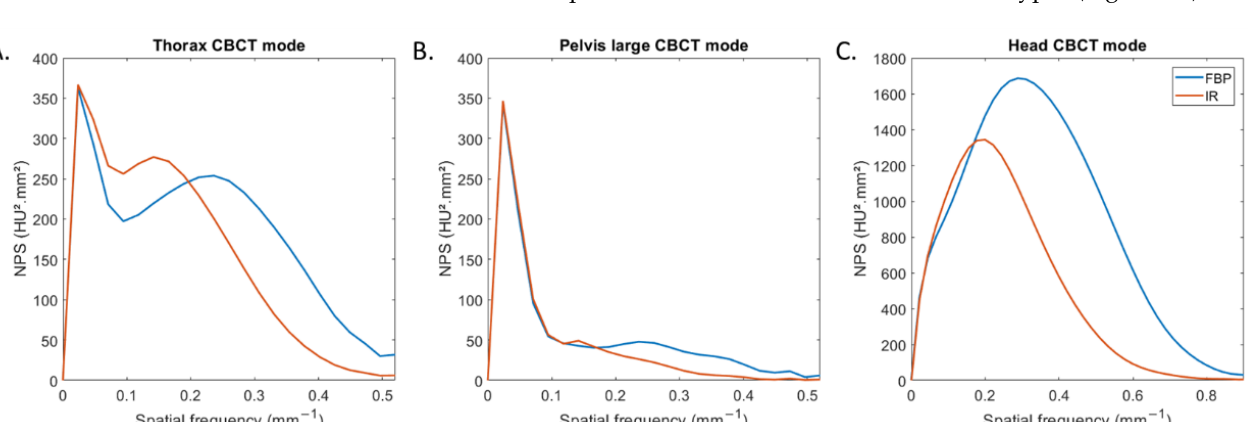
Figure 2. Noise power spectrum (NPS) curves obtained with filtered-back projection and iterative reconstruction for the three CBCT acquisition modes.